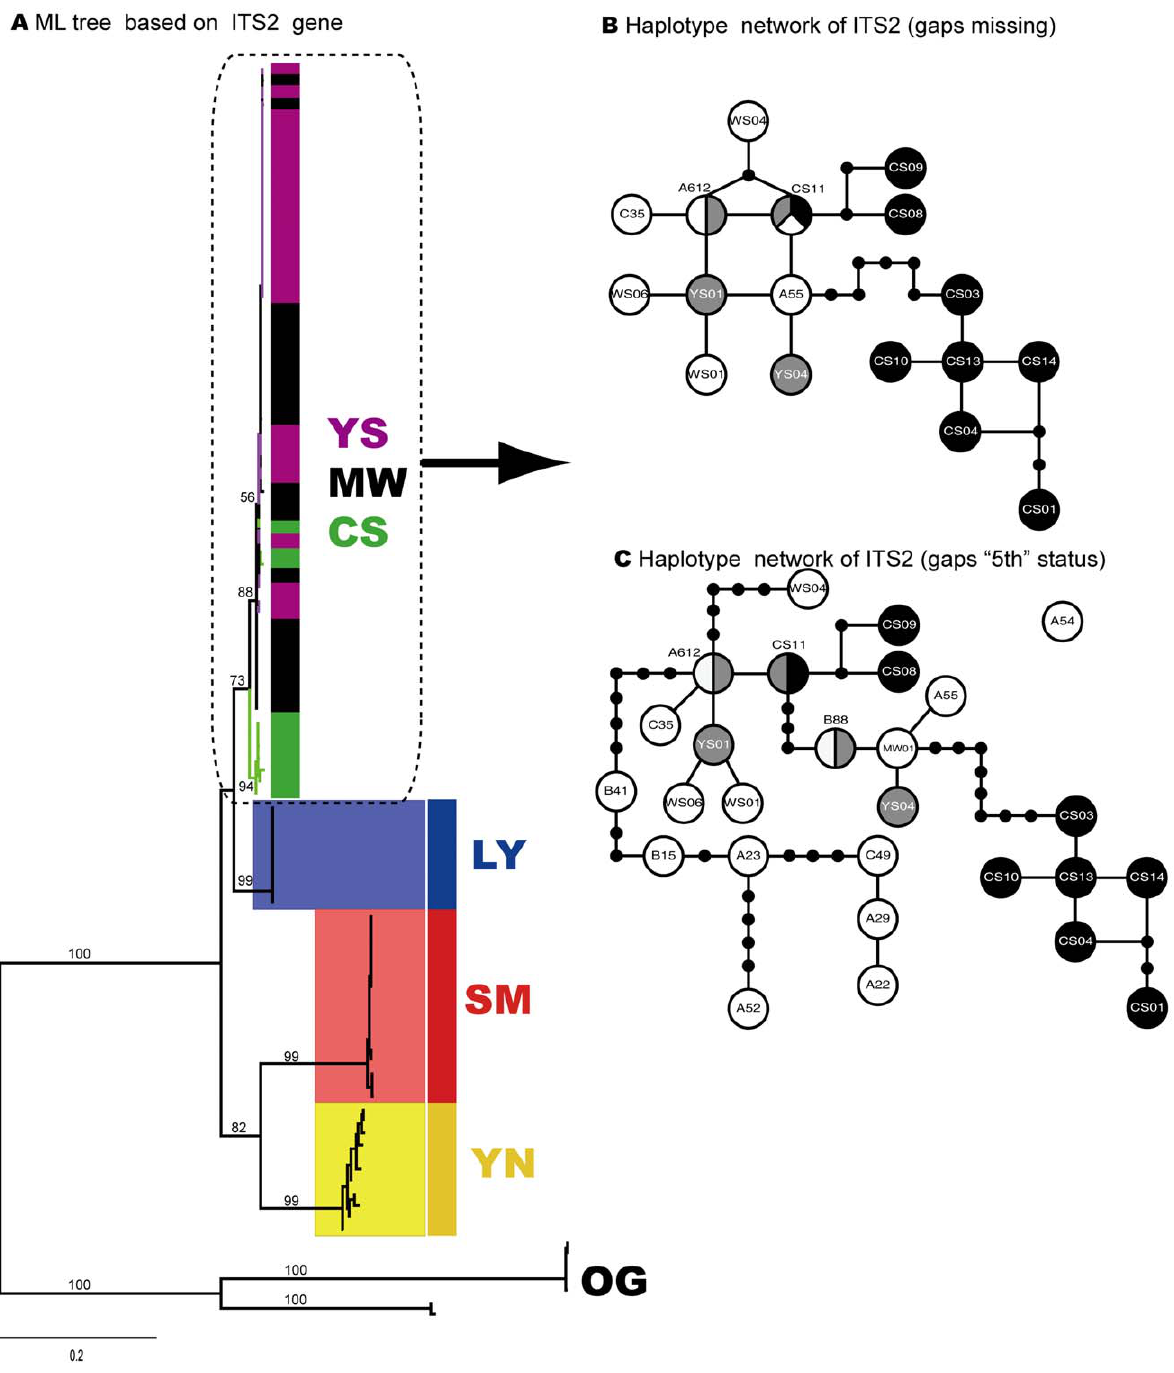
Figure 4. Phylogenetic trees (ML) of six Dendrolimus pine moth species constructed with single COI gene and Haplotype network for three mostly closely related species D.punctatus , D.tabulaeformis , D.spectabilis A) ML tree based on ITS2 gene; Clades with different colors indicate different species respectively. MW - D. punctatus , SM - D. kikuchii , YN - D. houi , YS - D. tabulaeformis , CS - D. spectabilis , LY - D. superans ; OG - OUTGROUP; Numbers above branches indicate bootstrap values (less than 50 not shown) (hereinafter). Clades with light blue branches indicate GMYC species, see text for details; B) Haplotype network of ITS2 gene (gaps missing); C) Haplotype network of ITS2 gene (gaps ‘‘5th’’ status). Empty circles mean haplotypes of species D. punctatus , gray circles indicate haplotypes of species D. tabulaeformis , and black circles represent haplotypes of species D. spectabilis . doi:10.1371/journal.pone.0032544.g004 rates (90.00%, 84.80%) than those of ITS barcodes (64.70%, and (ITS1-ITS2) presented much low species identification success rate 81.60%) with no statistic significance, but significantly lower than compared to those of the above mentioned two (Fig. 7c). The that of COI barcode (97.20%). The remaining two-gene system three-gene barcode (COI-ITS1-ITS2) obtained a success rate of